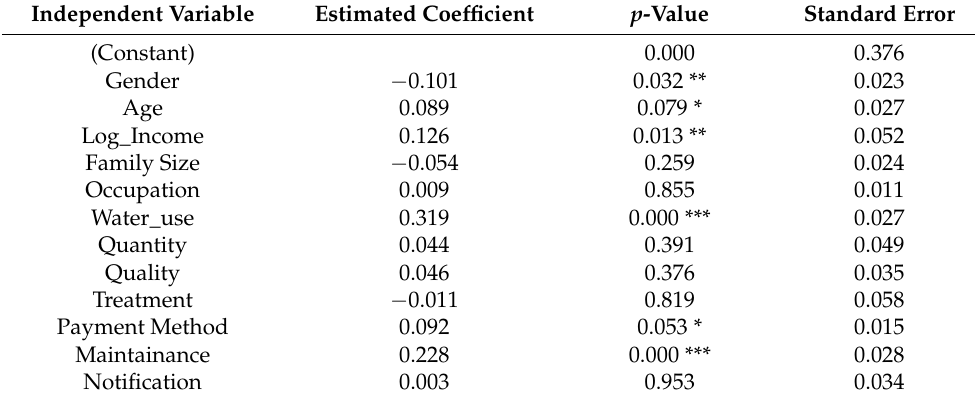
Table 8. WTP regression results for HUDWSS